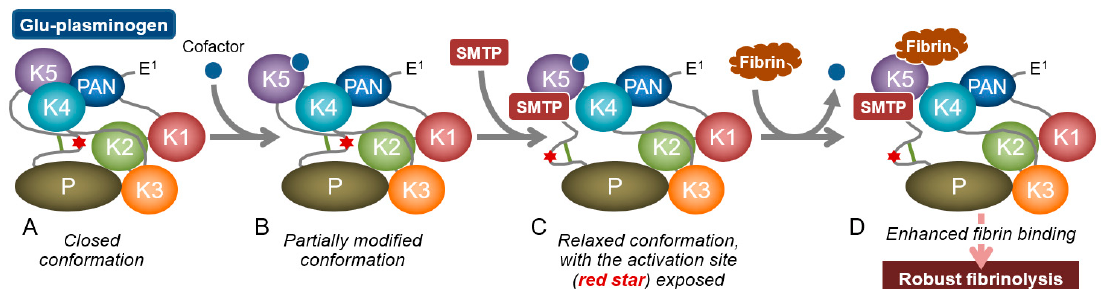
Figure 4. Proposed mechanism for the action of SMTP on plasminogen. ( A ) Schematic structure of Glu-plasminogen with closed spiral conformation, which is resistant to fibrin binding and plasminogen activator (PA)-catalyzed activation (see Figure 3 legend for designation of the symbol). The image incorporates essential structural information derived from crystallographic studies [94,95]. ( B ) An SMTP cofactor (phospholipid or unsaturated fatty acid) possibly binds to a site in K5 partly overlapping the aminohexyl site (see [98] for oleic acid–K5 binding) to modify the PAN–K5 interaction (image represents PAN–K5-disrupted molecule). ( C ) Cofactor-modified conformation may allow SMTP binding (possibly to K5, because SMTP does not affect micro-plasminogen, which lacks intact K5 [97]). SMTP binding leads to large-scale conformational change in plasminogen, enabling ( D ) robust fibrin binding and PA-catalyzed activation to plasmin (not shown). The resulting plasmin cleaves fibrin to yield C-terminal lysine, to which K1 (as well as K2 and K4) binds strongly, recruiting more plasminogen to accelerate fibrinolysis [99]. Thus, the promotion of plasminogen–fibrin binding and activation of the bound plasminogen in the early phase of fibrinolysis has a significant effect on the subsequent propagation phase. PAN, plasminogen–apple–nematode domain; K, kringle domain; P, protease